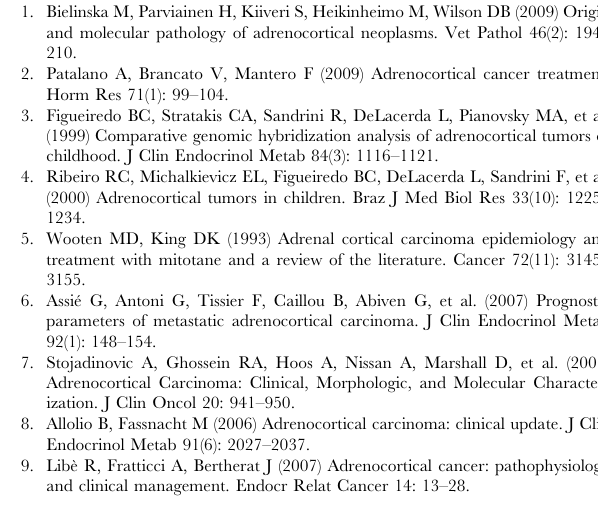
Table S1 TUNEL analysis after wt p53 over-expression and irradiation. H295R, SW-13 and SK-OV-3 cell lines were transfected with empty vector (mock) or p53- vector (WT) and subjected to ionizing radiation treatment at a dose of 6 Gy. Percentage of apoptosis was evaluated at 48 and 72 h after transfection (24 and 48 h from irradiation), by comparing TUNEL positive cells with Hoechst-positive, total, cells using ImageJ